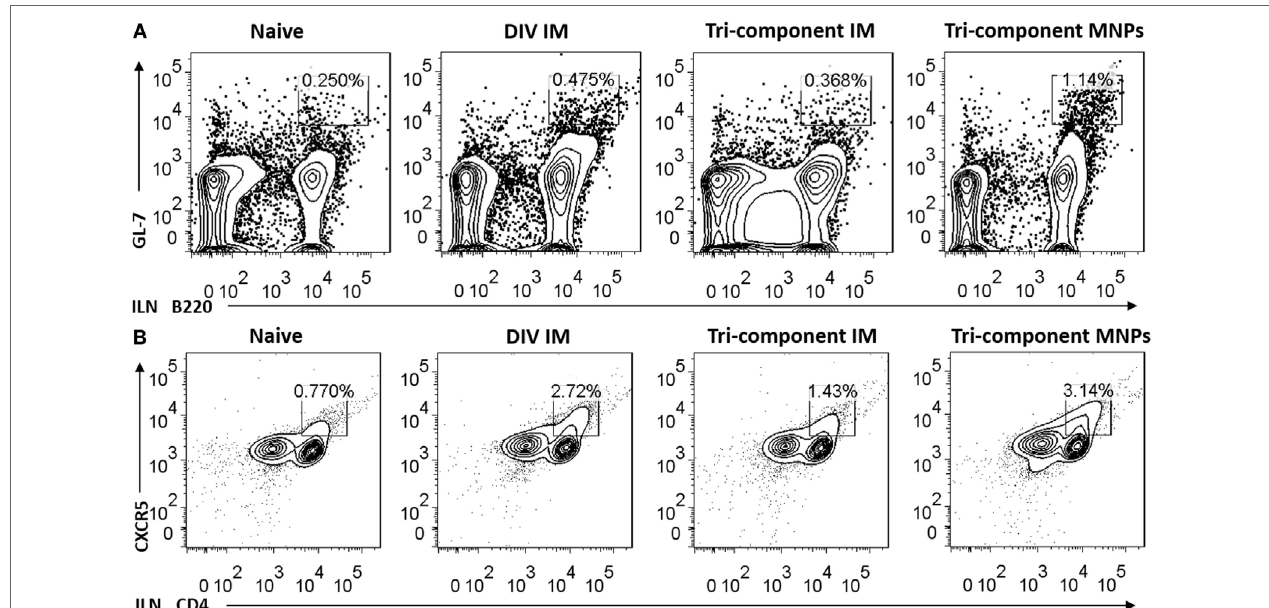
FigUre 3 | Microneedle patch immunization induced germinal center (GC) reactions in the draining lymph node. The number of GC B cells (a) and Tfh cells (B) from inguinal lymph nodes was determined 7 days post immunization by FACS ( N = 4). Data represent mean ± SEM. The statistical significance was analyzed by Student’s t -test. * p < 0.05, ** p < 0.01, *** p < 0.001, n.s p >